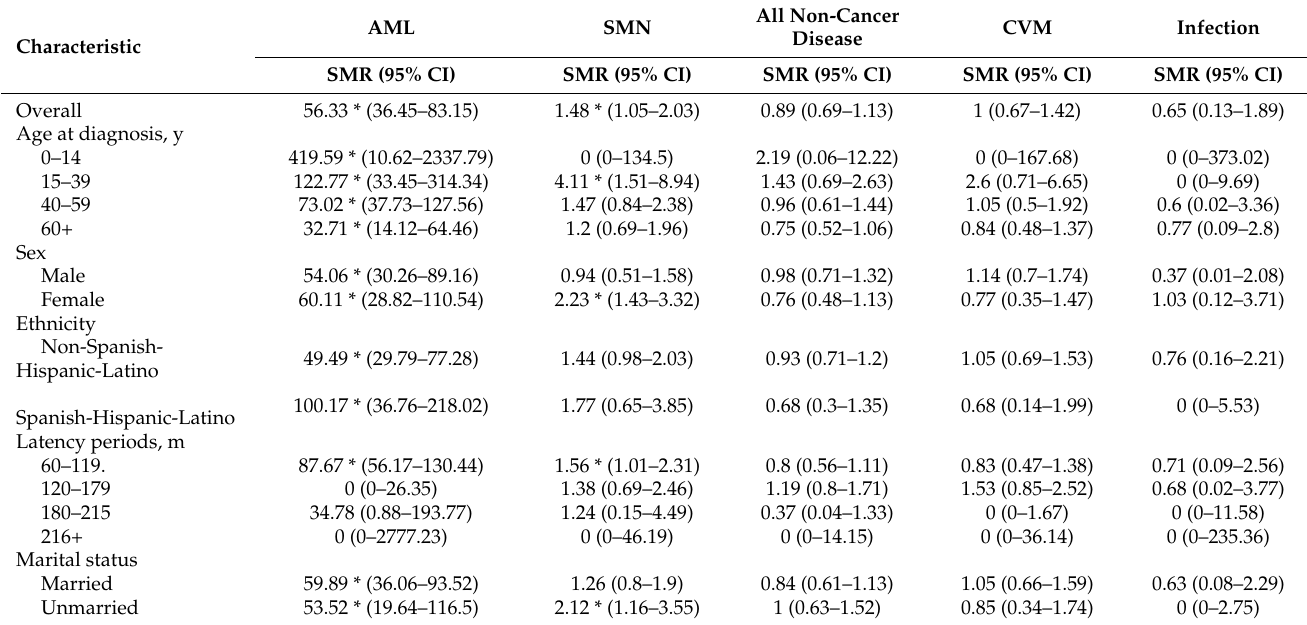
Standardized mortality ratios (SMRs) for 5-year survivors of APL according to baseline